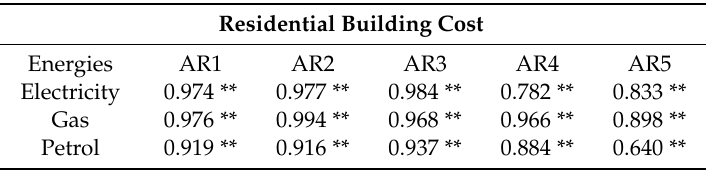
Table 1. Correlation analysis